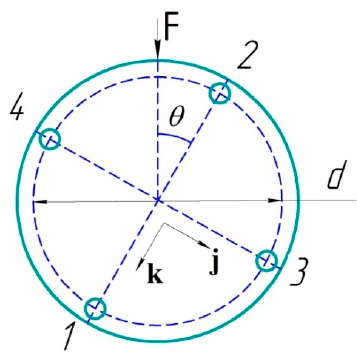
Figure 4. The diagram of the influence on the sensor. The angle θ determines the angle between the direction of external force F applied onto the sensor and the axis, going through the cores 2 and 1.